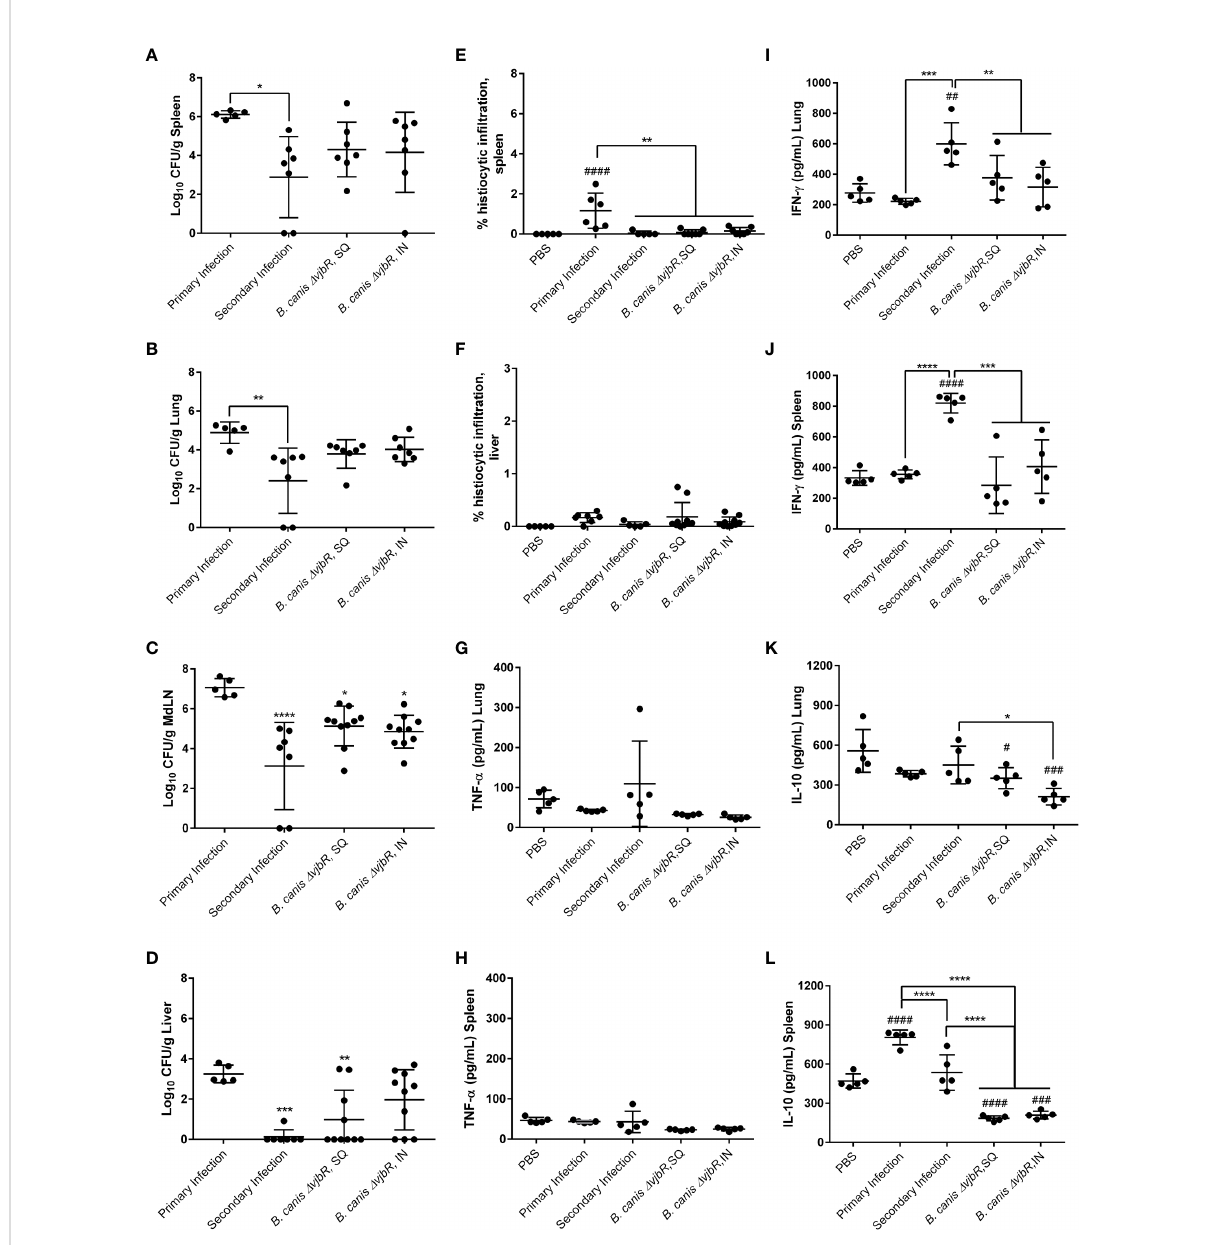
FIGURE 8 Previous infection or vaccination, regardless of route, protect mice against secondary intratracheal challenge with B . canis but superior protection is offered by previous infection, associated with higher IFN- g and IL-10 compared to vaccination. Mice were infected with 10 7 CFU B . canis or vaccinated with 10 9 CFU of B . canis D vjbR subcutaneously or intranasally. Vaccinated mice were challenged at 6-weeks post-vaccination. Colonization 2-weeks post-primary infection or challenge offemale C57BL/6J mice with 10 7 CFU B. canis in the (A) spleen, (B) lungs, (C) mediastinal lymph node (MdLN), and (D) liver. Data points represent the mean bacterial recovery in CFU per gram of tissue plus the standard deviation for all animals in each infection group. Quanti fi cation of % histiocytic in fi ltration within the (E) spleen and (F) liver at 2-weeks post-infection. Measurement of cytokines in lung and spleen homogenate supernatants at 2-weeks post-challenge, including (G, H) TNF- a , (I, J) IFN- g and (K, L) IL-10. Data were analyzed using via one-way ANOVA and Tukey ’ s multiple comparisons test. Data were analyzed via one-way ANOVA and Tukey ’ s multiple comparisons test. Signi fi cant differences are depicted between infection groups (*p < 0.05, **p < 0.01, ***p < 0.001, ****p < 0.0001) and between infection groups and the PBS negative control group (#p < 0.05, ##p < 0.01, ###p < 0.001, ####p <